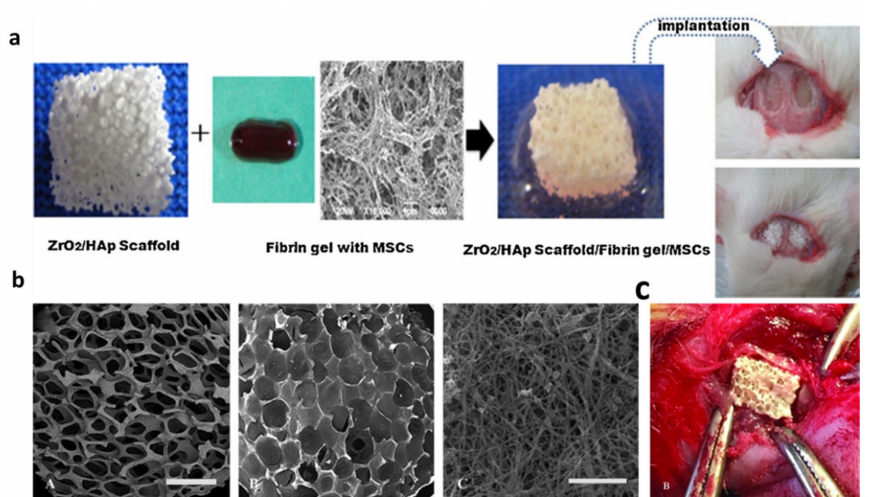
Figure 1. ( a ) Fabrication of the zirconia/HA scaffold via polyurethane foam-scaffold technique and its successful bone-regeneration in eight-week-old male Sprague dawley (SD) rats. Image is used from An et al., reprinted with permission from Elsevier [20], copyright© 2012. ( b ) PRP-impregnated HA/zirconia frameworks: ( A – C ) high-resolution SEM outputs of the PRP-impregnated HA/zirconia frameworks. ( c ) In vivo experiment for PRP-impregnated HA/zirconia frameworks; ( B ) in vivo demonstrations via a rectangular bone defect in the rabbit mandible and replacement of the defect using the deliberately designed rectangular scaffolds. Image used from Shahsavari-pour et al. [47], reprinted with permission from Elsevier, copyright©